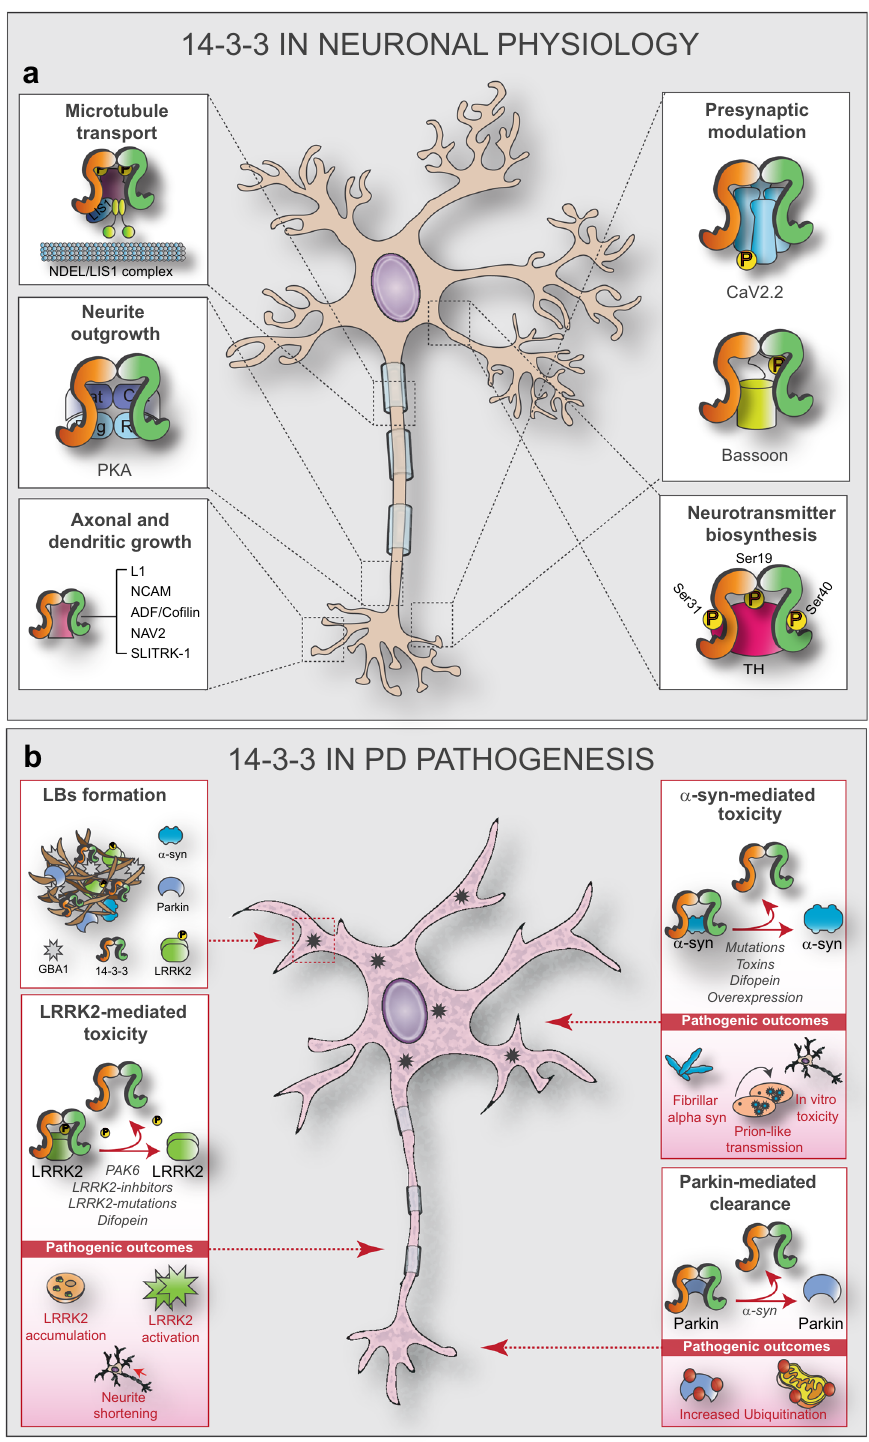
Fig. 3 Roles of 14-3-3 in the healthy and PD brain. The roles of 14-3-3s in physiological conditions ( a ) and its involvement in PD ( b ). a NDEL/ LIS: nuclear distribution gene E-like homolog 1/Lissencephaly-1; PKA: protein kinase A; NCAM: neural cell adhesion molecule; ADF/Co fi lin: actin-depolymerizing factor/Co fi lin; NAV2: neuron navigator 2; SLITRK-1: SLIT and NTRK-like family, member 1; CaV2.2: N-type voltage-gated Ca2 + channel; Bassoon; TH: tyrosine hydroxylase. b GBA: glucosylceramidase beta; LRRK2: leucine-rich repeat kinase 2; α -Syn: α -Synuclein; PAK6: P21-activated kinase